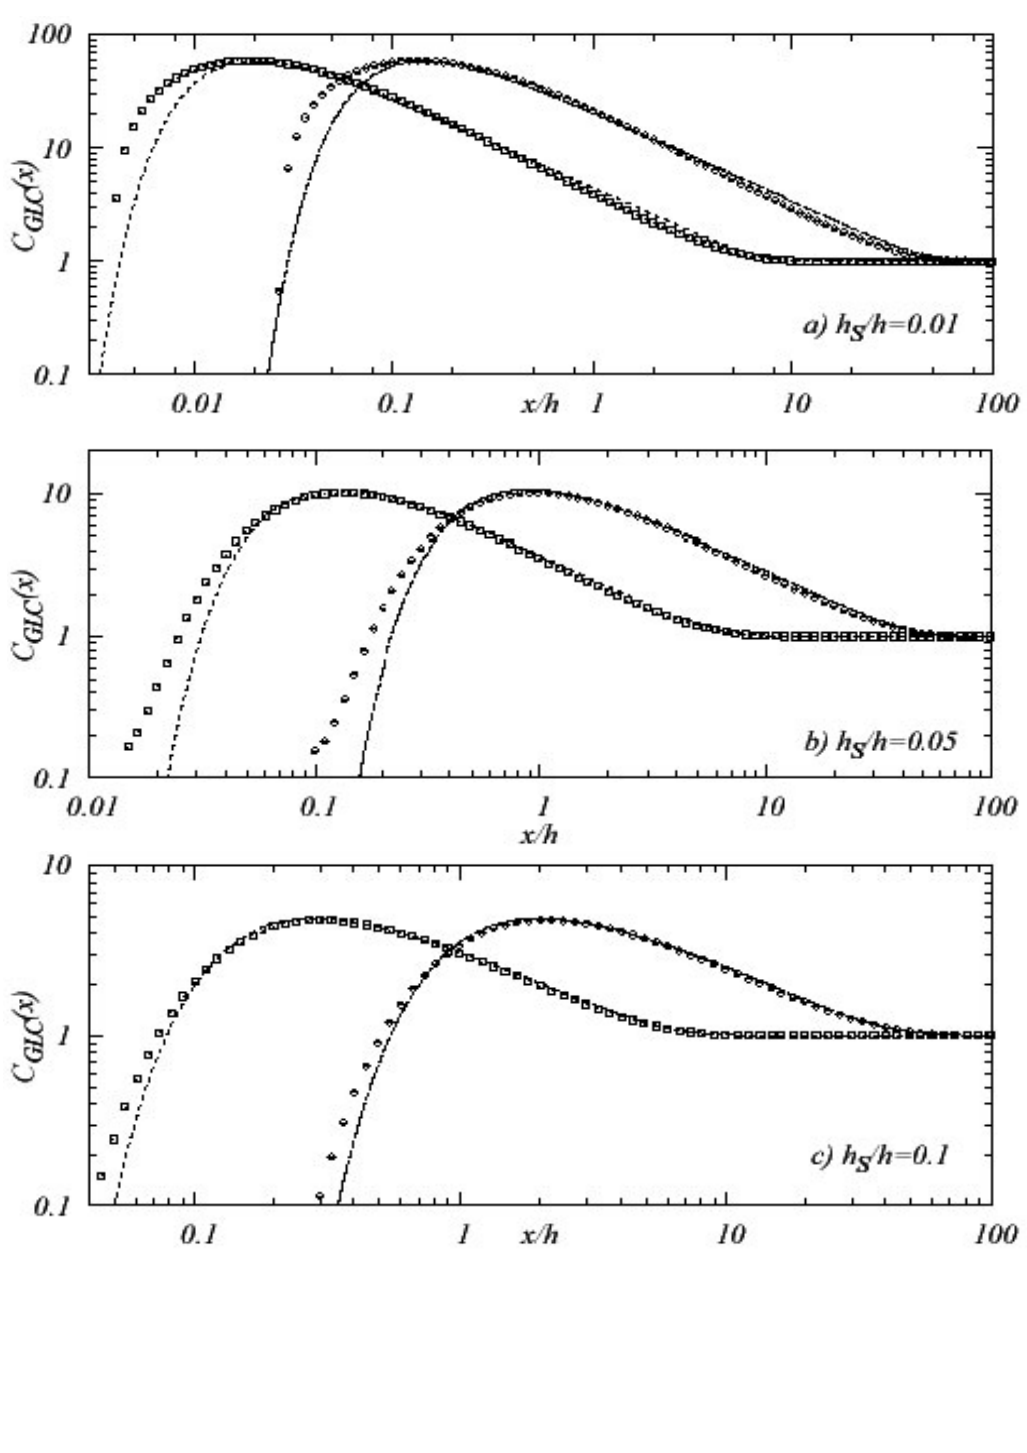
01.0~ 05.0~ 1.0~ ~ h , ( b ) h , and ( c ) h . Points refer to for ( a )    s s s 099.0~ 001.0~ L , empty circles L   MO MO